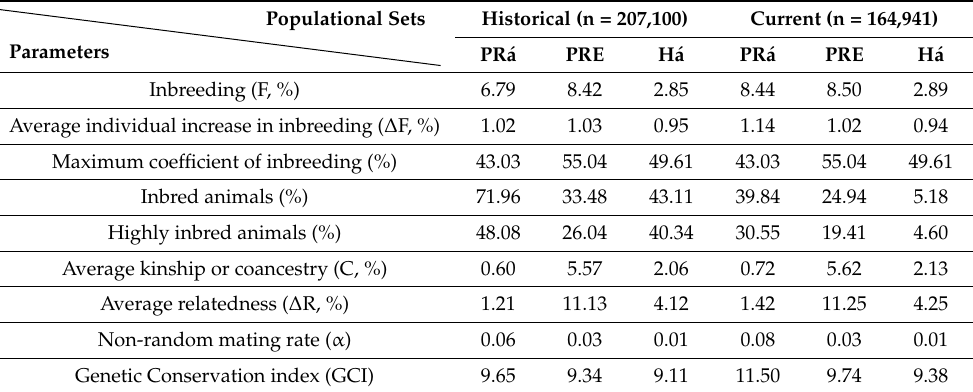
Table 4. Statistics of pedigree analysis: inbreeding (F), average individual increase in inbreeding ( ∆ F, %), maximum coefficient of inbreeding (%), inbred and highly inbred animals (%), average coancestry (C, %), average relatedness ( ∆ R, %), non-random mating rate ( α ), and genetic conservation index (GCI).